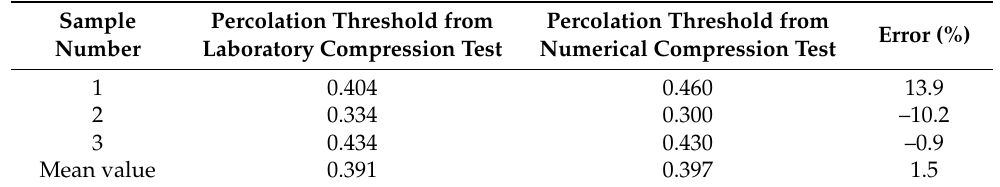
Table 3. Comparison of percolation thresholds obtained by numerical simulation and by laboratory compression